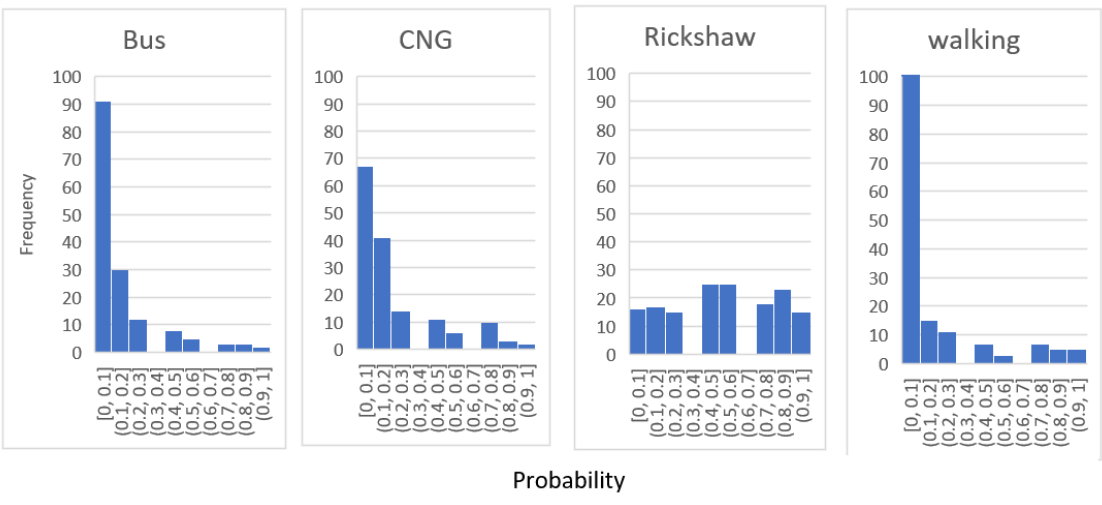
Figure 9. Probability of selecting bus, CNG, rickshaw, and walking by KNN for test data.